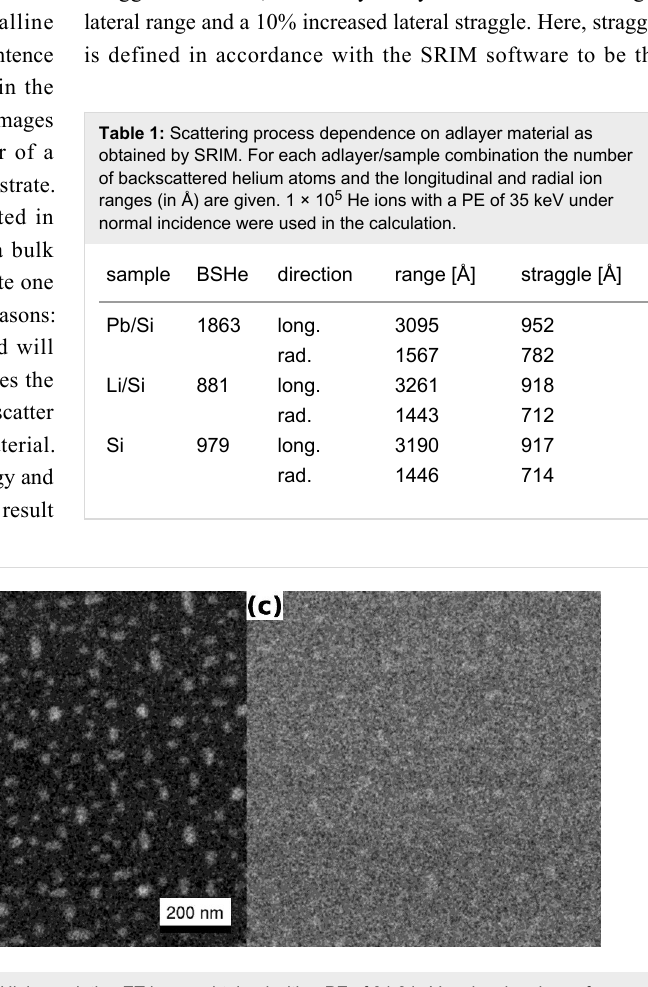
Figure 3: Co-containing nanocrystals on Ge{001} (FoV: 1 μ m) (a) High-resolution ET image obtained with a PE of 34.6 keV and an ion dose of 1.05 × 10 16 cm − 2 . Aligned Co-containing nanocrystals are visible. The average extent of the crystals is between 10 nm and 60 nm laterally with a height of around 5 nm. (b) BSHe image obtained under normal incident with a PE of 10 keV and an ion dose of 1.05 × 10 16 cm − 2 . The Co-containing nanocrystals are clearly visible. (c) BSHe image recorded under identical conditions as used in (b) but with an incident angle of 10°. Reprinted from [10], copyright (2012) with permission from Elsevier.